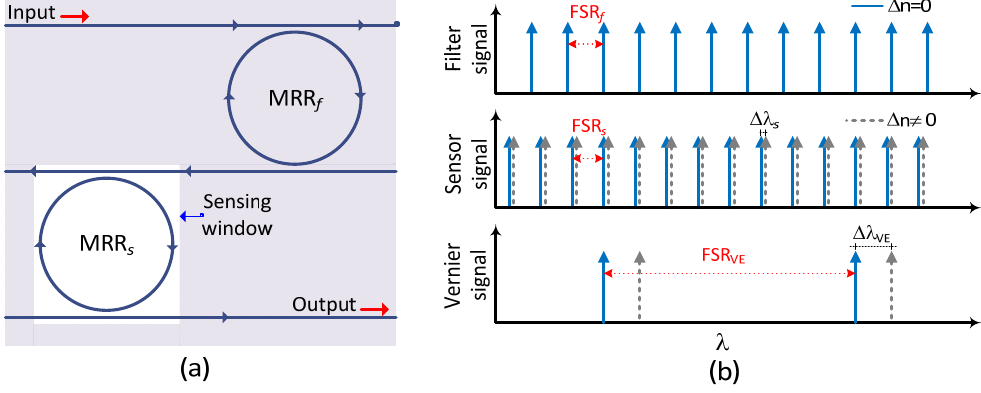
Figure 1. ( a ) Schematic architecture of the optical sensor based on CMRRs. ( b ) Vernier principle employed for sensing